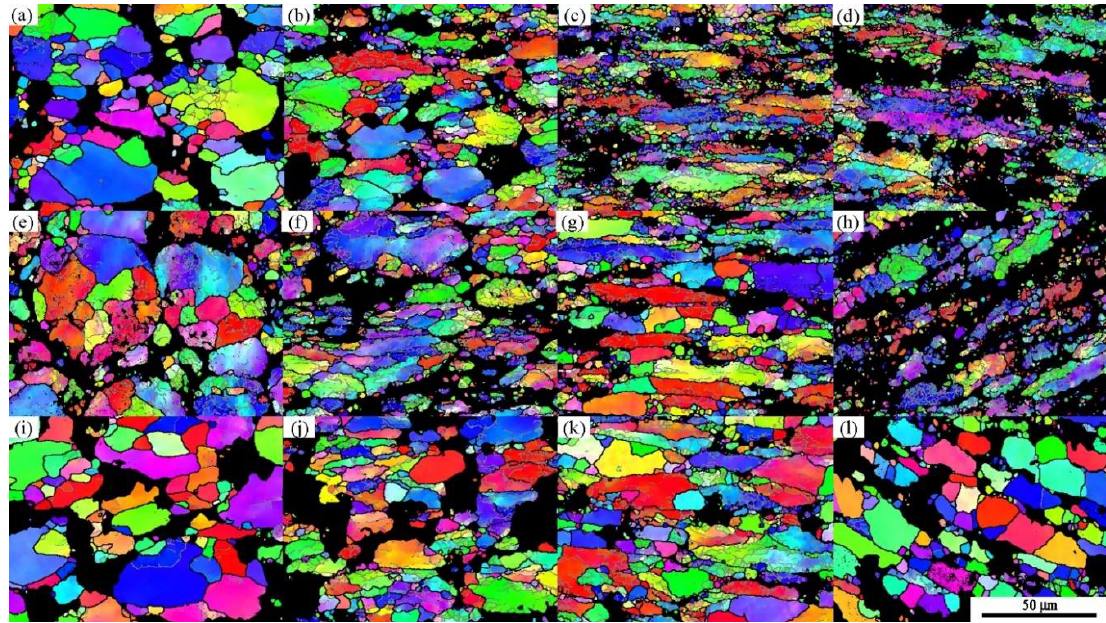
Figure 6. An EBSD image of the composite matrix microstructure at a deformation temperature of 400 °C for ( a ) ε = 0.07 and 0.54 s − 1 ; ( b ) ε = 0.11 and 0.22 s − 1 ; ( c ) ε = 0.17 and 0.05 s − 1 ; ( d ) ε = 0.34 and 2.32 s − 1 ; ( e ) ε = 0.43 and 0.81 s − 1 ; ( f ) ε = 0.49 and 0.15 s − 1 ; ( g ) ε = 0.60 and 4.06 s − 1 ; ( h ) ε = 0.63 and 4.29 s − 1 ; ( i ) ε = 0.79 and 1.47 s − 1 ; ( j ) ε = 0.83 and 0.25 s − 1 ; ( k ) ε = 0.88 and 1.64 s − 1 ; ( l ) ε = 0.92 and 0.28 s − 1